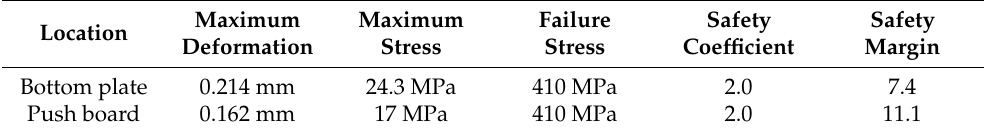
Table 2. Quasi-static acceleration analysis results.